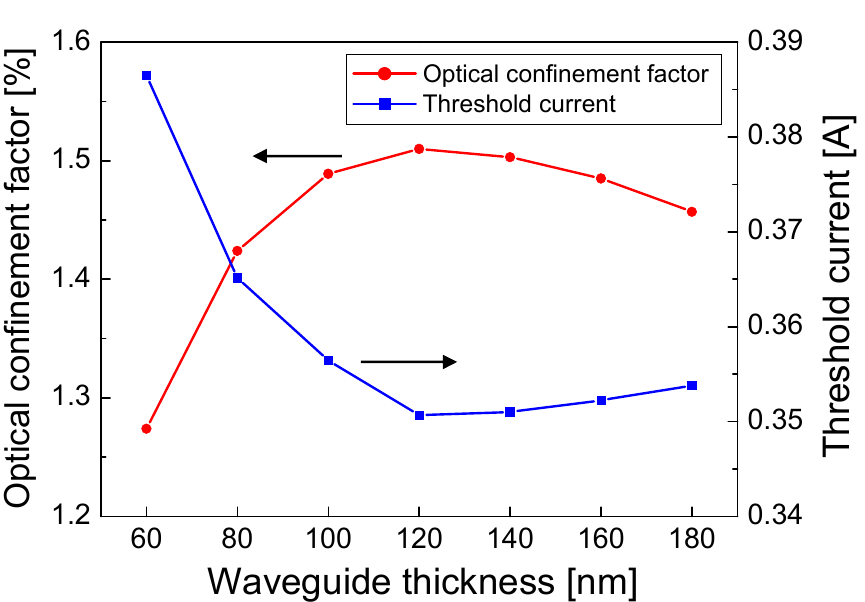
Figure 4. Optical confinement factor (left axis) and threshold current (right axis) as a function of the thickness below and above the MQW layers.